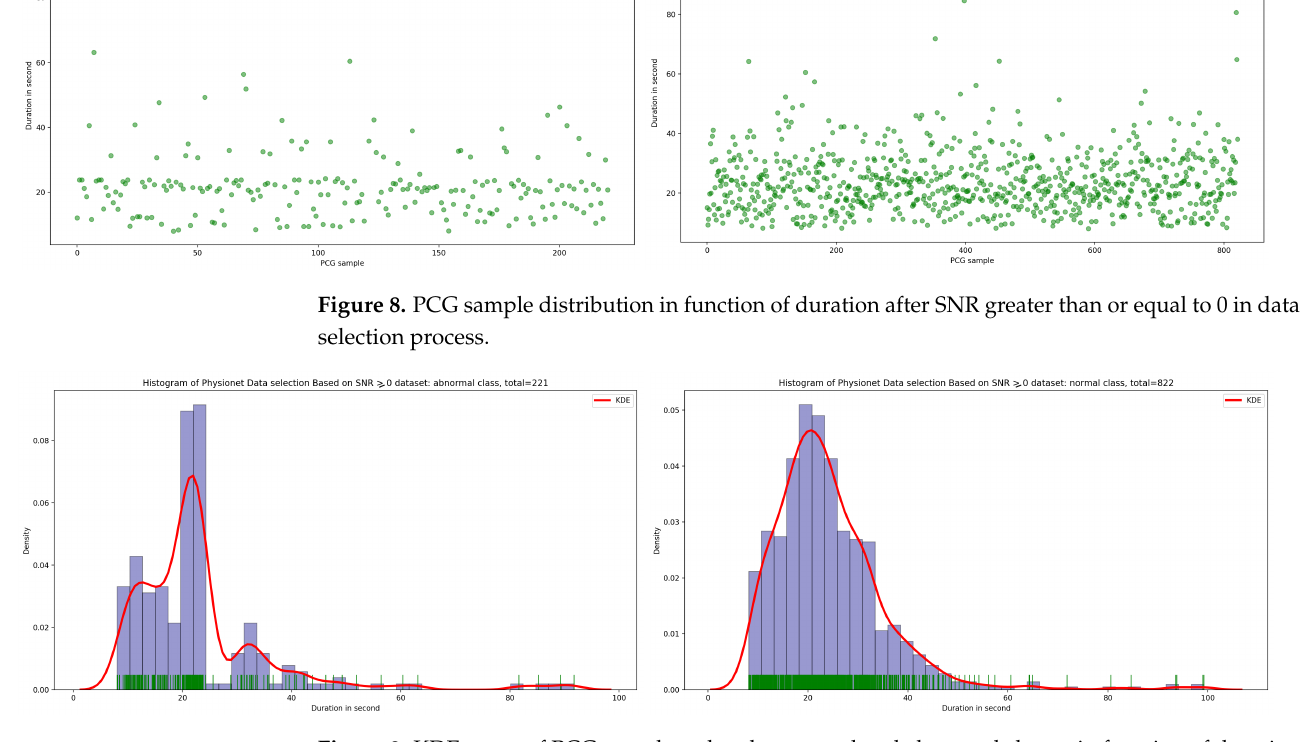
Figure 9. KDE curve of PCG samples related to normal and abnormal classes in function of duration after SNR greater than or equal to 0 in data selection process.